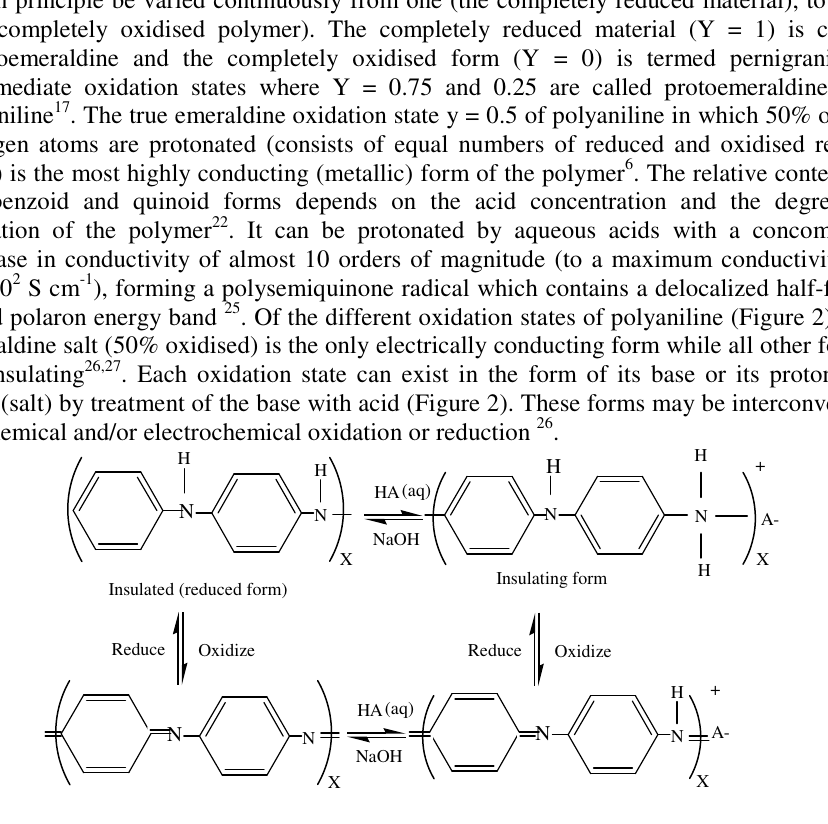
Figure 2 . Four redox forms of